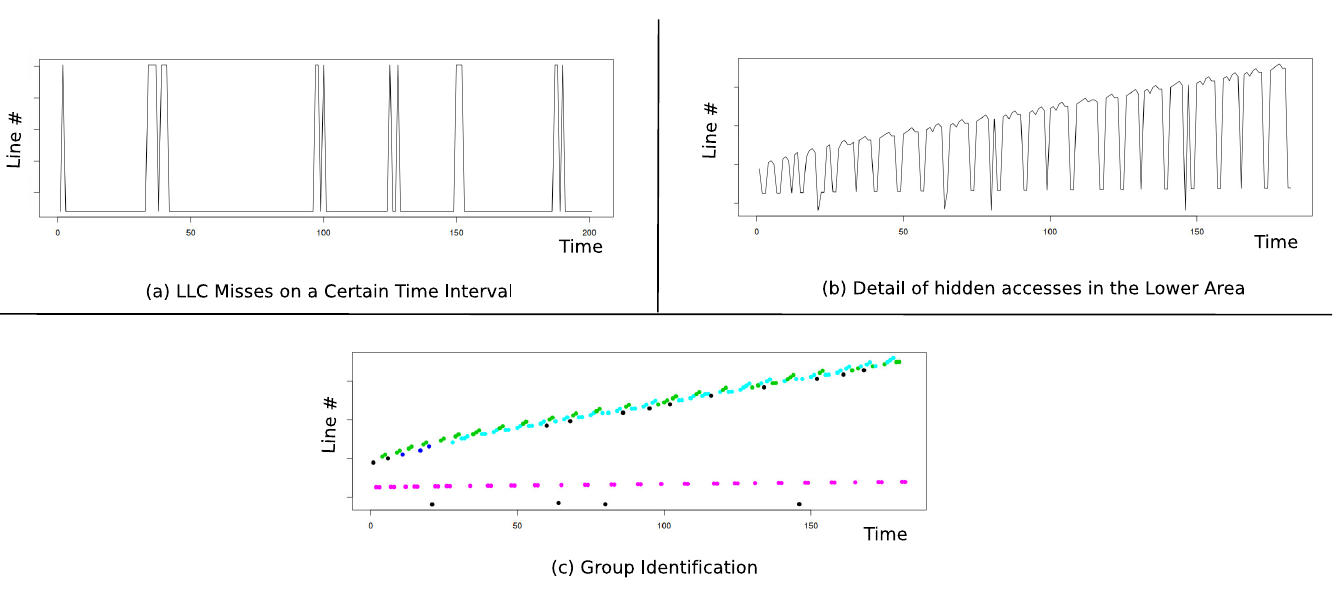
Fig 7. Example of astar spatial locality. Algorithmic complexity in astar with multiple simultaneous groups that are isolated and identified by our HMM proposal. In (c) the different groups are represented by colors.